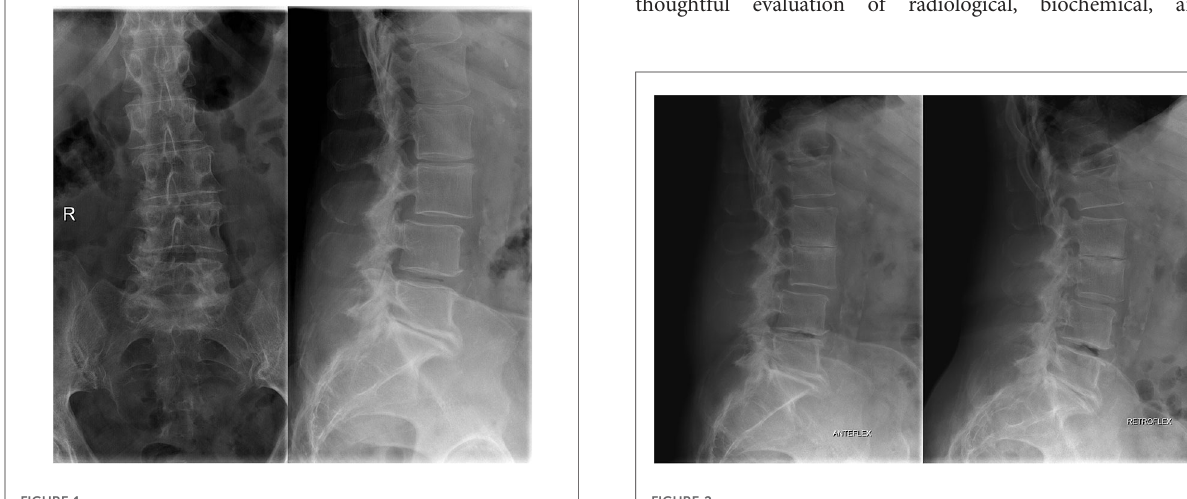
FIGURE 1 Preoperative standing x-ray prior to index surgery: anteroposterior view (left) and lateral view (right).